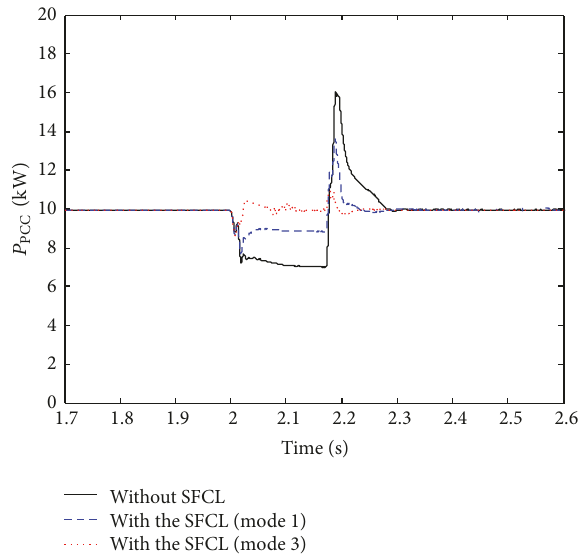
Figure 18: Influence of the active SFCL on the PCC power under the asymmetrical fault.